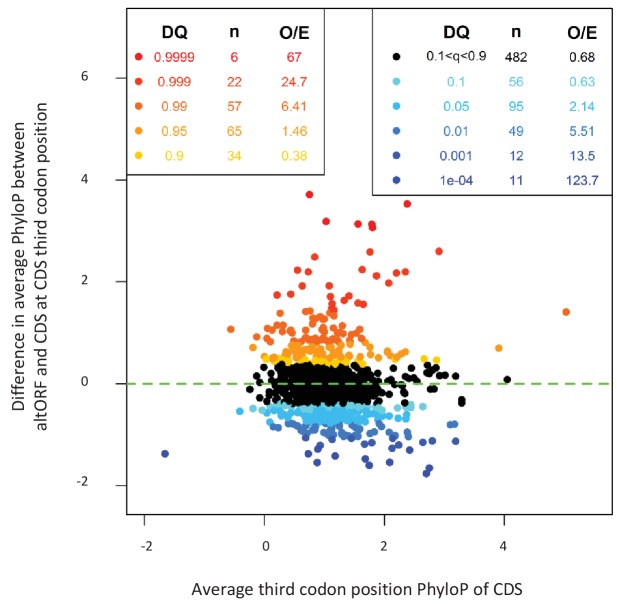
AltORFs completely nested within CDSs show more extreme PhyloP values (more conserved or faster evolving) than their CDSs.Differences between altORF and CDS PhyloP scores (altORF PhyloP – CDS PhyloP, y-axis) are plotted against PhyloPs for their respective CDSs (x-axis). We restricted the analysis to altORF-CDS pairs that were conserved from humans to zebrafish. The plot contains 889 CDSs containing at least one fully nested altORF, paired with one of its altORFs selected at random (to avoid problems with statistical non-independence). PhyloPs for both altORFs and CDSs are based on third codons in the CDS reading frame, calculated across 100 vertebrate species. We compared these differences to those generated based on five random regions in CDSs with a similar length as altORFs. Expected quantiles of the differences (‘DQ’ columns) were identified and compared to the observed differences. We show the absolute numbers (‘n’) and observed-to-expected ratios (‘O/E’) for each quantile. There are clearly substantial over-representations of extreme values (red signaling conservation DQ 0.95, and blue signaling accelerated evolution DQ 0.05) with 317 of 889 altORFs (35.7%). A random distribution would have implied a total of 10% (or 89) of altORFs in the extreme values. This suggests that 25.7% (35.7delete–10%) of these 889 altORFs undergo specific selection different from random regions in their CDSs with a similar length distribution.10.7554/eLife.27860.013Figure 3—source data 1.Number of orthologous and co-conserved alternative and reference proteins between H. sapiens and other species (pairwise).